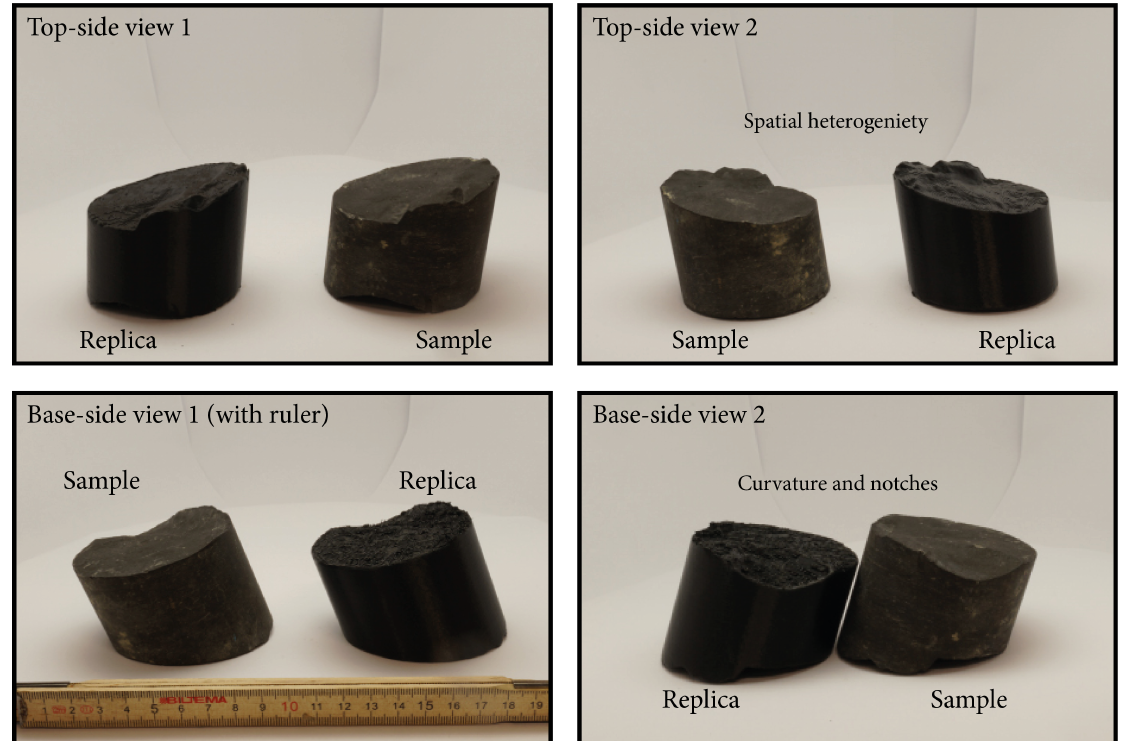
Figure 5. Comparison of a 3D printed replica and the original drill core sample. Such a comparison was implemented as a first quality indicator for the equivalence of the dimensions and